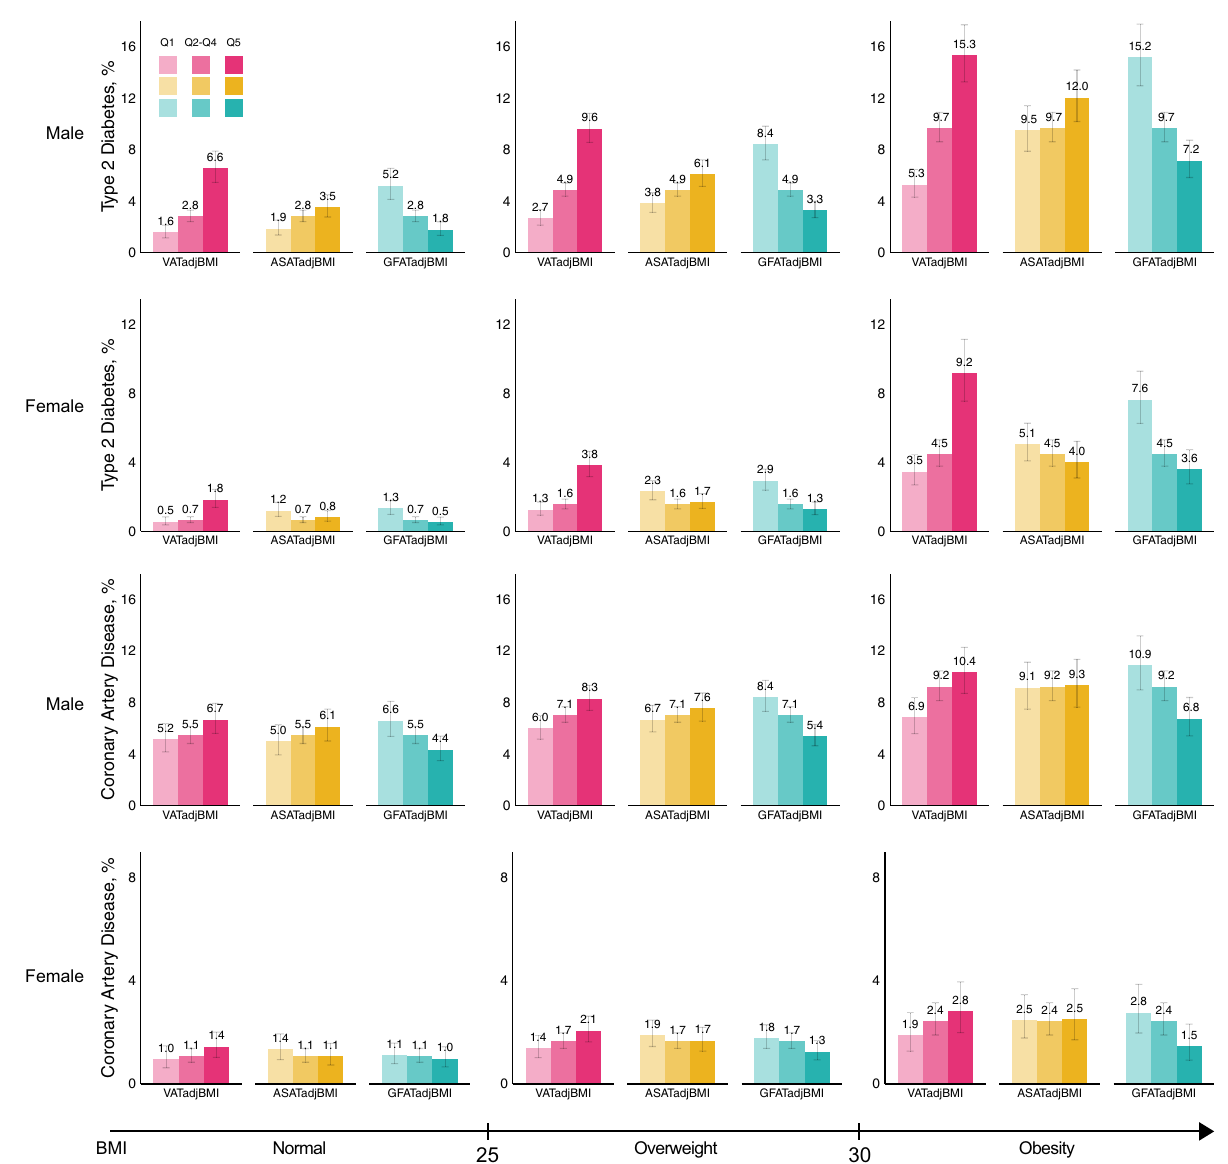
Fig.4|Standardizedprevalenceoftype2diabetesandcoronaryarterydisease, according to quintiles of body-mass index adjusted fat depot and body-mass index strata. Standardized prevalence with 95% con fi dence intervals are repor- ted from sex-strati fi ed logistic regressions including age, BMI, MRI imaging center, sex-speci fi c quintiles of three local adiposity metrics (VATadjBMI, ASA- TadjBMI,GFATadjBMI),andinteractionterms betweenBMI andeachofthelocal adiposity metrics. 18,810 male participants and 19,870 female participants were used for each logistic regression model, respectively. For each fat depot, the